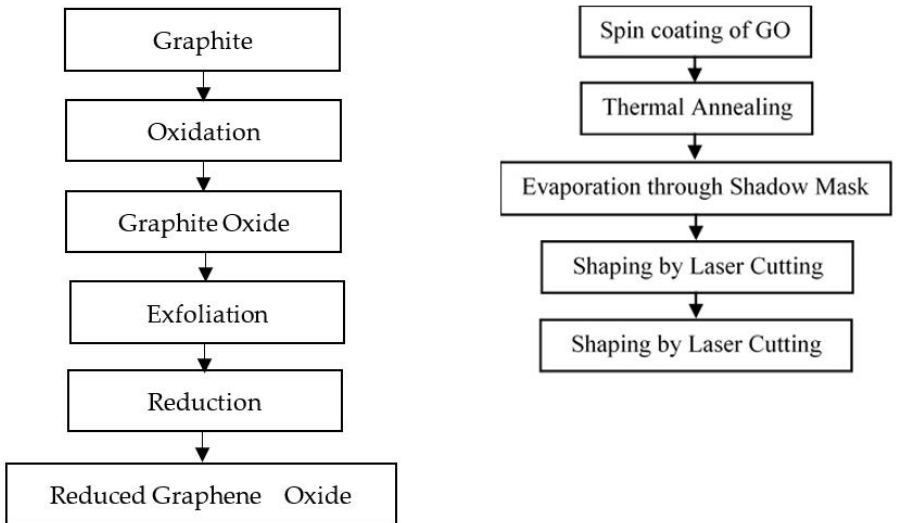
Figure 2. The overall schematic of the electrode fabrication.